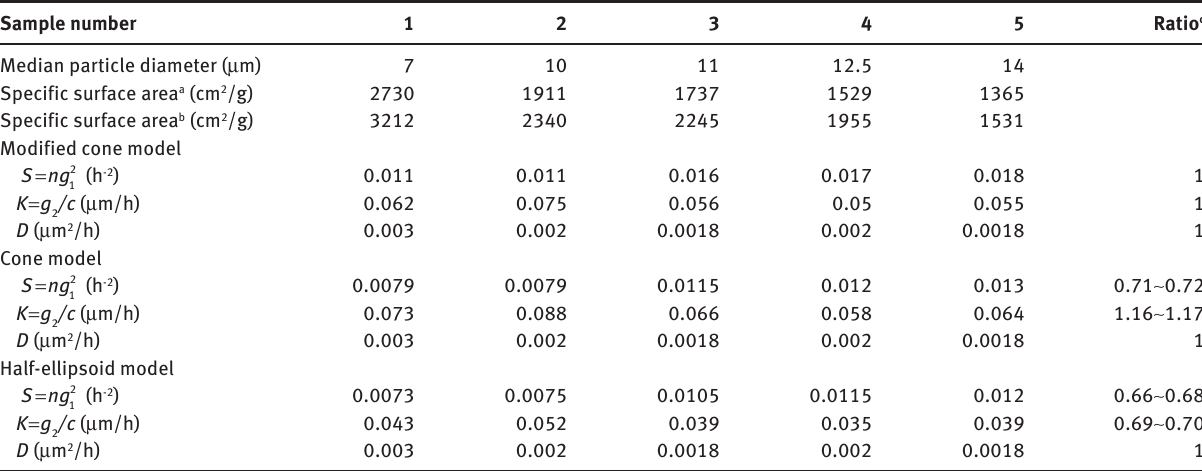
Table 1 Model parameters for different particle size